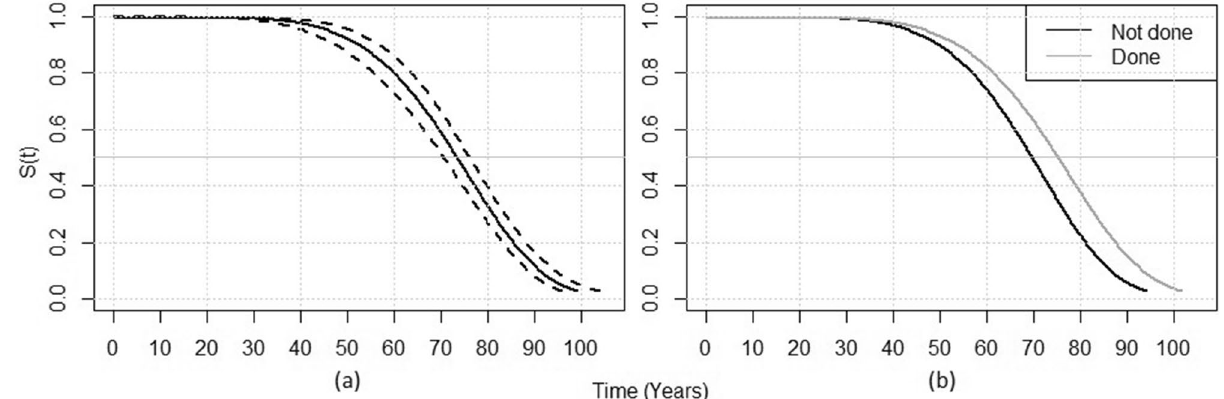
Figure 3. Posterior survival distributions for the IDA group, showing ( a ) the baseline survival probability at any given time S(t), with dashed lines representing the credibility interval, and ( b ) the survival probabilities for sub-groups categorised by whether a blood count was done in the two years prior to the presentation